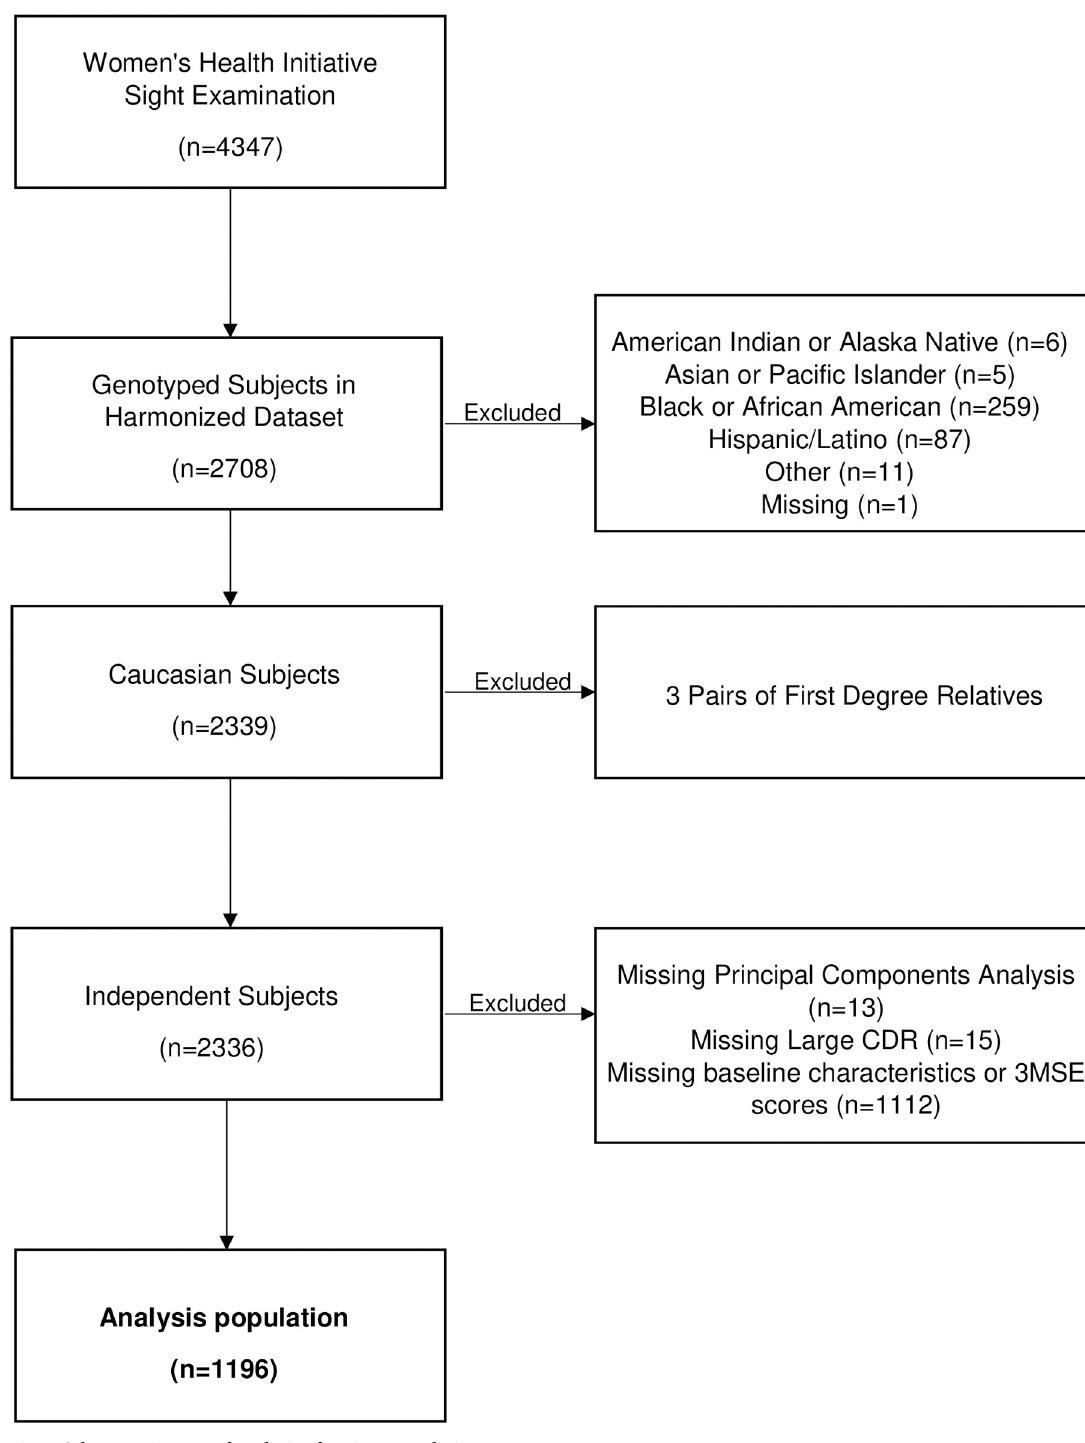
Fig 2. Schema: Diagram of analysis of patient population.